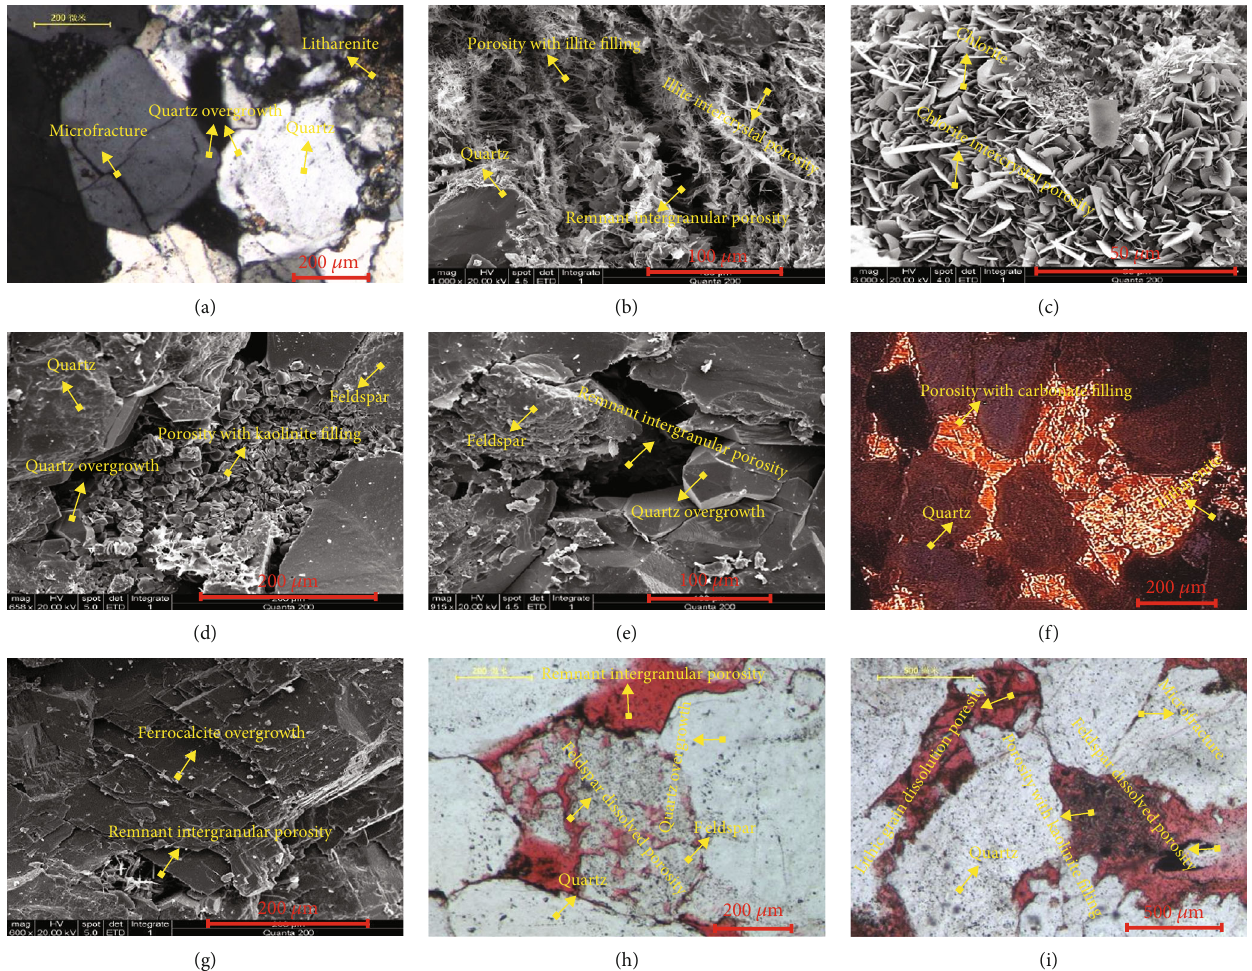
Figure 8: Microscope features of diagenesis of samples in the research area. (a) WellY169, 2629.70 m, CTS. (b) Well Y168, 2513.97 m, SEM. (c) Well Y120, 2560.29m, SEM. (d) Well Y126, 2718.98 m, SEM. (e) Well Y120, 2708.69m, SEM. (f) Well Y165, 2501.65 m, CL. (g) Well Y126, 2718.98m, SEM. (h) Well Y165, 2614.57m, CTS. (i) Well Y218, 2612.53 m, CTS. Table 2: Quantitative calculation method of porosity evolution in sandstone reservoir (modi fi ed from [39, 40]). Parameters of porosity evolution Formula Primary porosity,